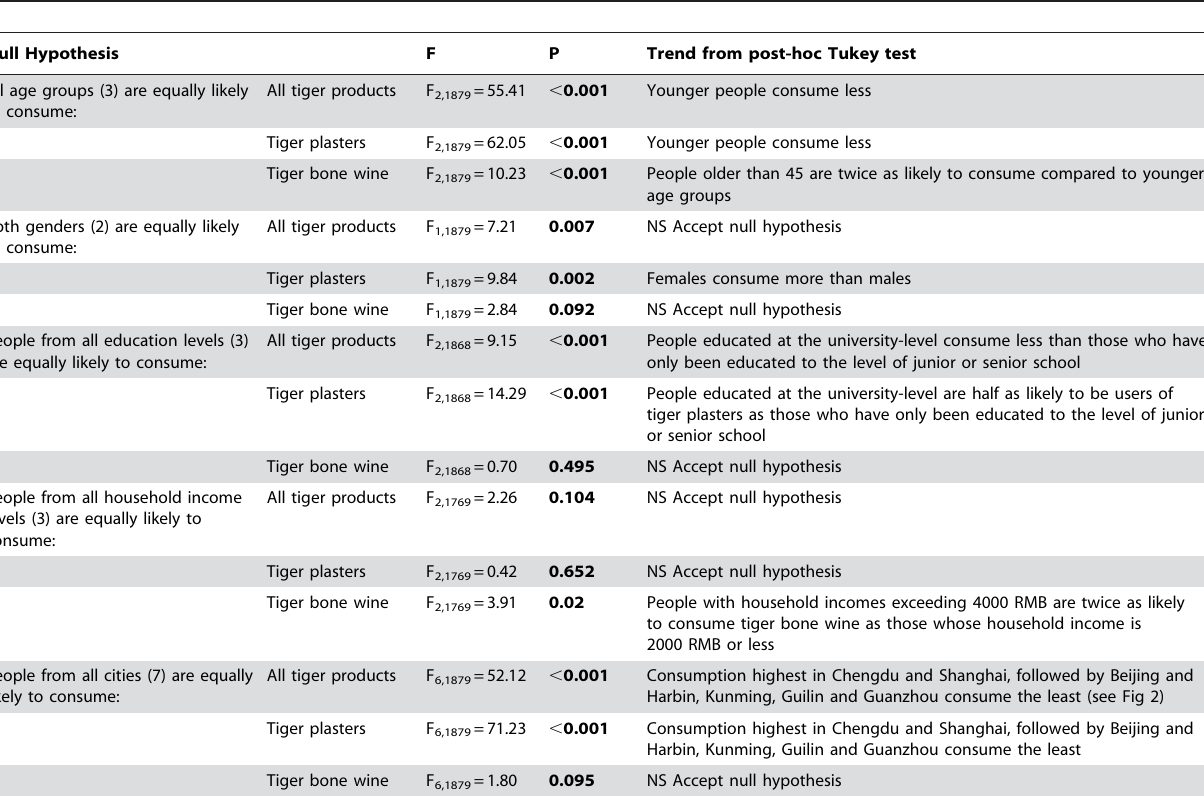
Table 2. The demographics of tiger consumption: Summary results of one-way ANOVAs testing null hypotheses about tiger consumption